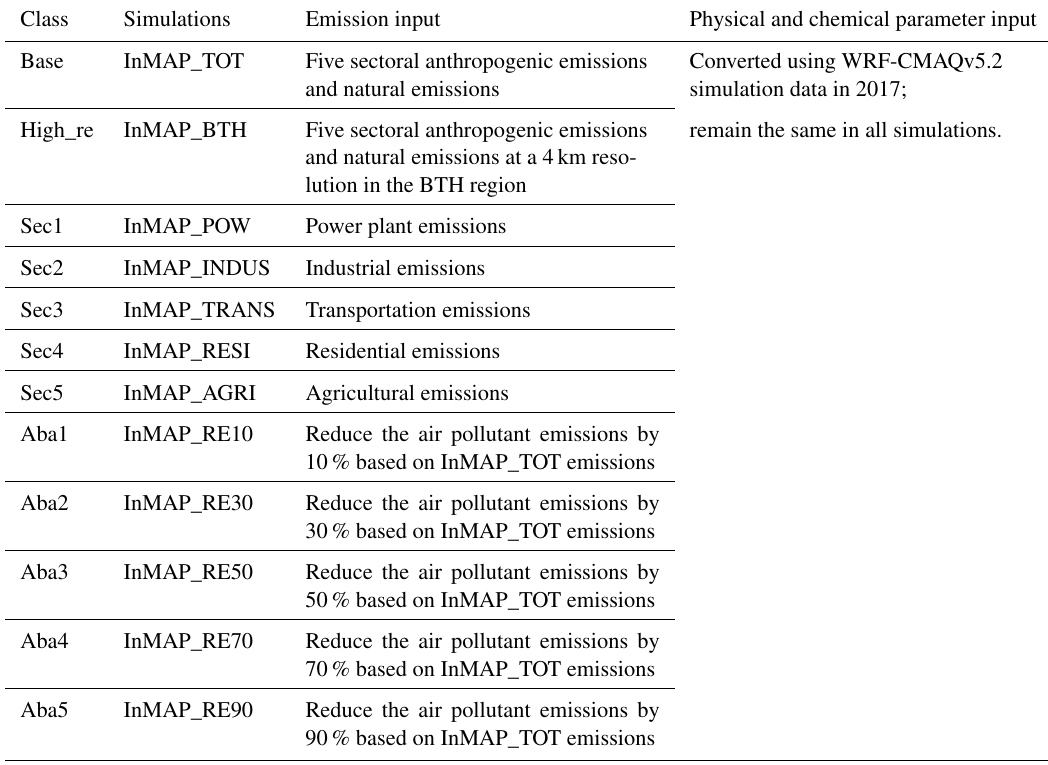
Table 3. Simulation experiments conducted using InMAP-China. Class Simulations Emission input Physical and chemical parameter input Base InMAP_TOT Five sectoral anthropogenic emissions Converted using WRF-CMAQv5.2 and natural emissions simulation data in 2017; remain the same in all High_re InMAP_BTH Five sectoral anthropogenic emissions and natural emissions at a 4km reso- lution in the BTH region